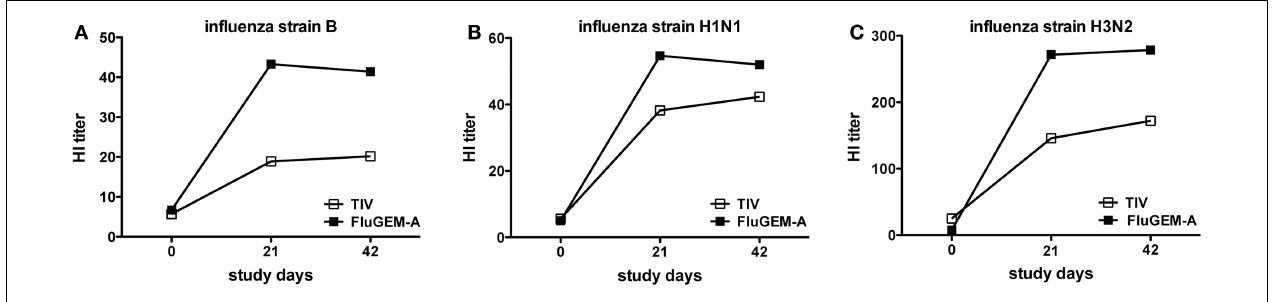
all three influenza strains, responses induced by i.n. vaccination with FluGEM-A were faster and of higher-magnitude, when compared to responses induced by i.n. vaccination withTIV (barely reach protective titer of 40).